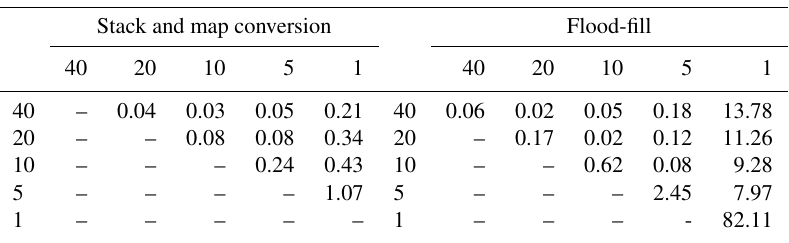
Table 2. Computation time in seconds for stack and map conversion between different resolutions and for flood-filling at different resolutions with different starting stacks, for the 40, 20, 10, 5 and 1km series. Stack and map conversion